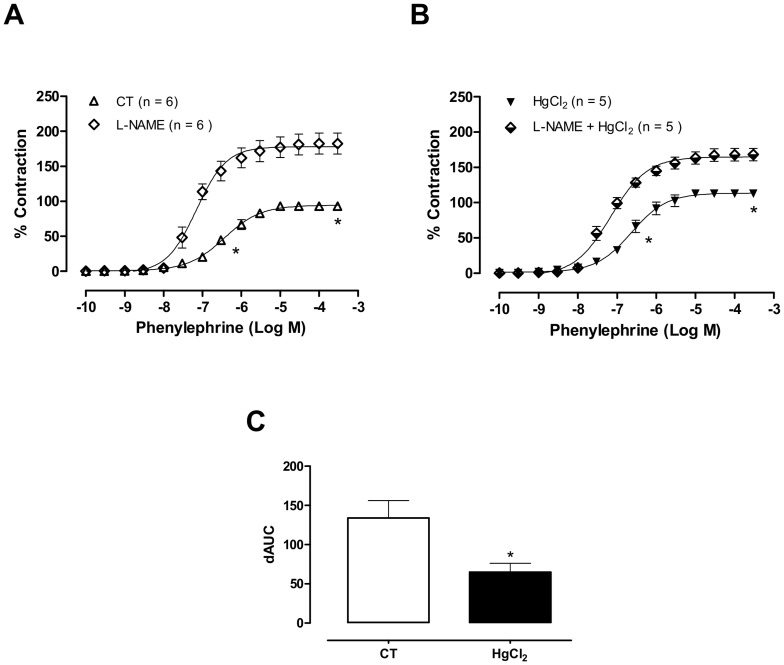
The effect of L-NAME (100 µM) on the concentration-response curves for phenylephrine in aortic rings in control (CT) conditions or HgCl2 (A,B).Results (mean±SEM) are expressed as a percentage of the response to 75 mmol/l KCl. *P<0.05 by ANOVA. Number of animals used in parentheses. (C) Differences in the area under the concentration-response curve (dAUC) for aortic rings incubated in the presence and absence of L-NAME in controls (CT) or HgCl2. *P<0.05 by Student’s t-test.